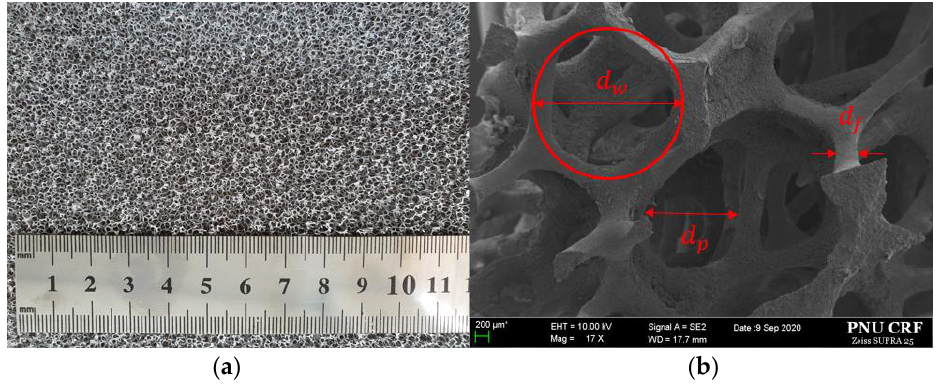
Figure 1. Real-size images ( a ) and SEM images of porous media ( b ). Table 1. Geometrical characteristics of porous media.